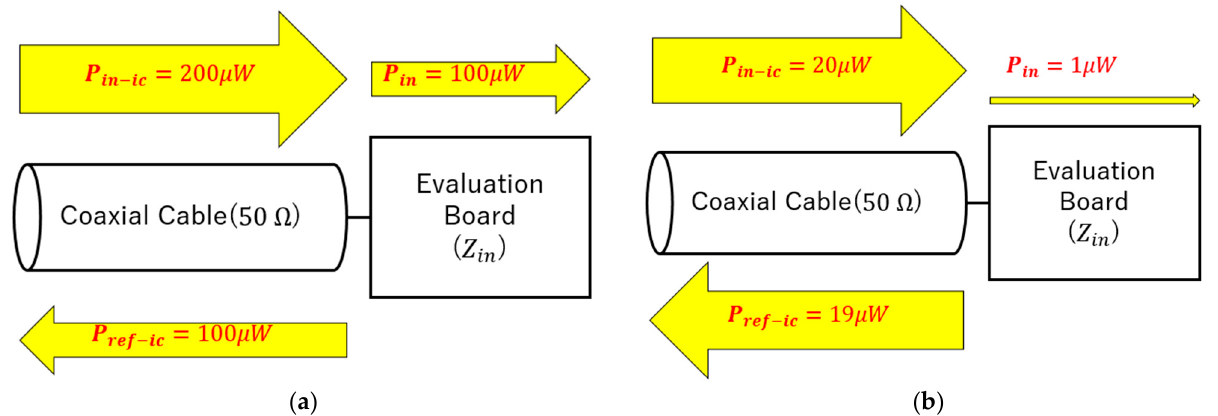
Figure 16. Difference of power reflection ratio caused by input power dependence of input impedance of the rectifier: ( a ) case of P in = 100 µ W; ( b ) case of P in = 1 µ W.